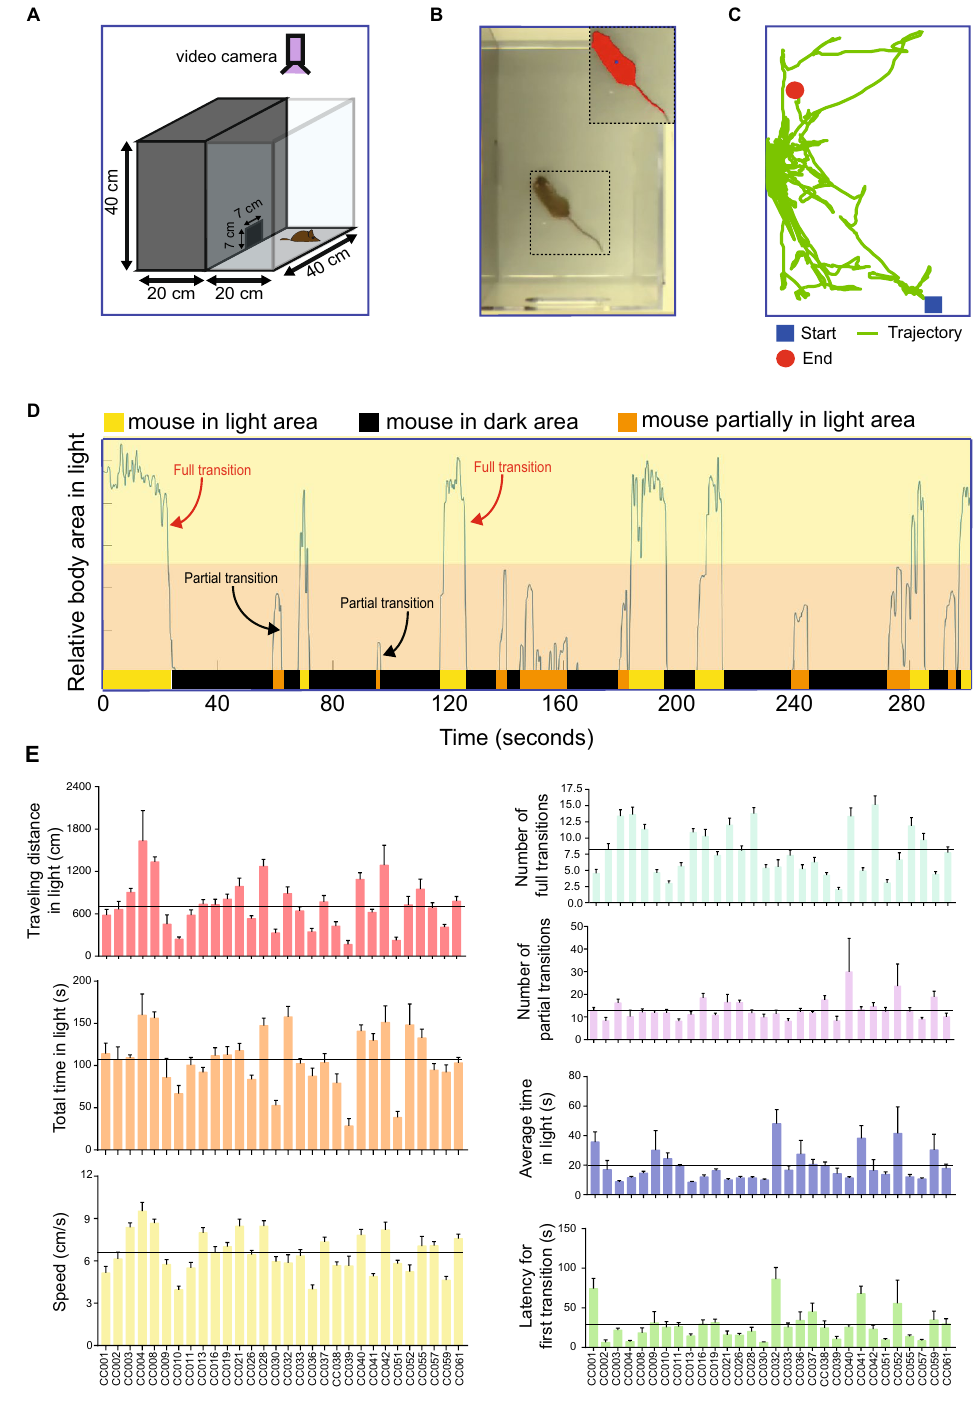
Figure 1. Measurement of anxiety-related phenotypes in Collaborative Cross mice using the light-dark box. ( A ) Dimensions of the light-dark box. ( B ) Mouse behavior video tracking in the light compartment. ( C ) Trajectory of a single mouse in the light compartment. The trajectory is indicated with a green line. The start and end points are indicated with a blue box and red circle, respectively. ( D ) Representative profile of mouse behavior in the light-dark box during the 300 second assay time. Transitions between the light and dark compartments was determined by measuring the relative body area in the light compartment. The bar at the bottom of the profile indicates the presence of the mouse in the dark area (black), the light area (yellow) or in between the light and dark compartments (orange). ( E ) Average measurements of seven anxiety-related phenotypes across CC strains. Bars indicate the mean measurement and error bars indicate standard deviation. The horizontal line indicates the mean value across all